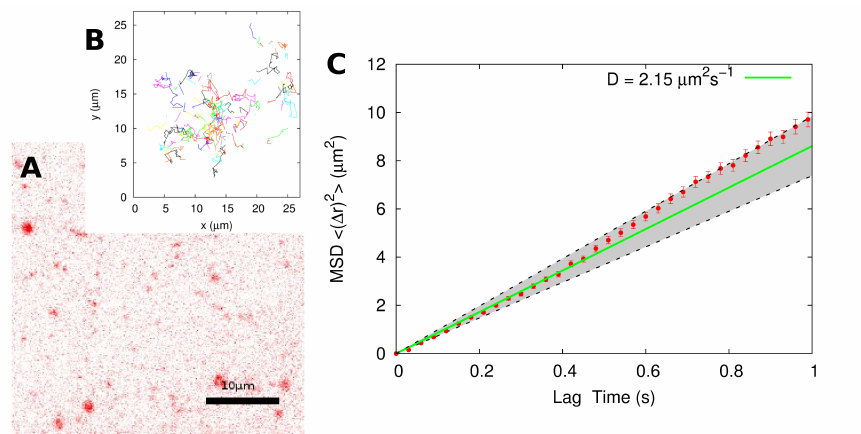
Figure 3. ( A ) Image of a mitochondria-like lipid bilayer imaged with TIRF microscopy. Image size: 41 µ m × 41 µ m; pixel size: d = 160 nm; frame interval: δ = 30 ms. ( B ) Tracks